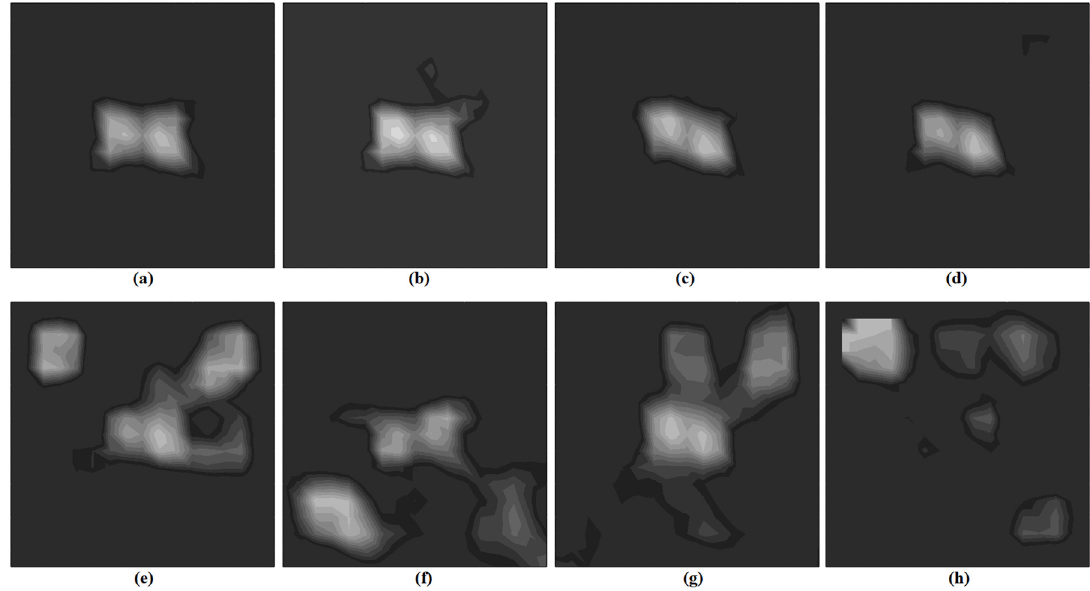
Figure 23. Noise study considering Unitcell-2 results for Damage Case-1; contour plots of I D for different noise levels (threshold = 0.5): ( a ) 2.5%, ( b ) 5%, ( c ) 7.5%, ( d ) 10%, ( e ) 12.5%, ( f ) 15%, ( g ) 17.5%, and ( h ) 20%.